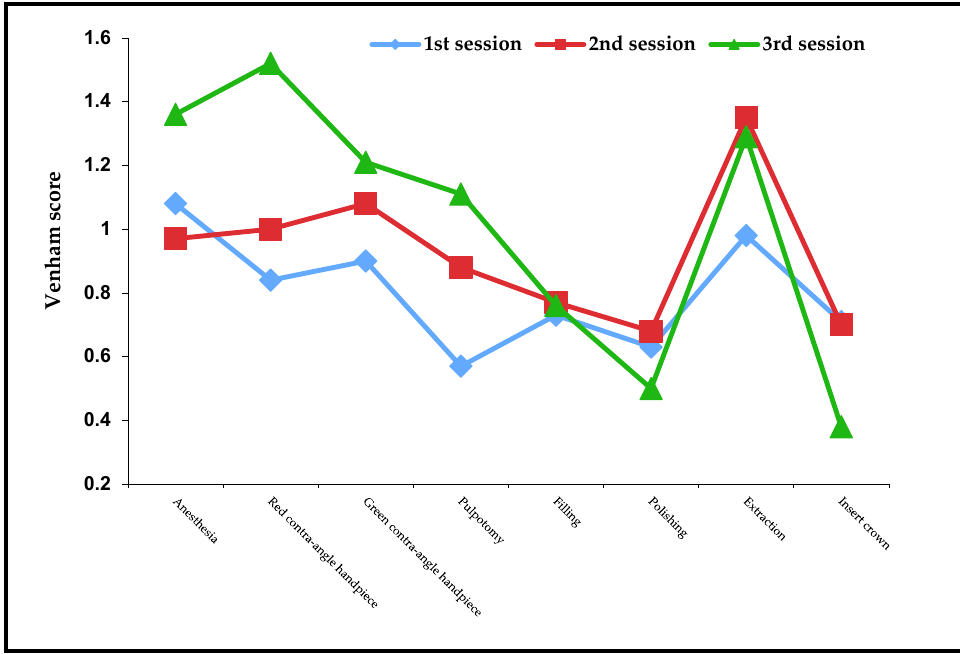
Figure 2. Venham score of the individual treatments .